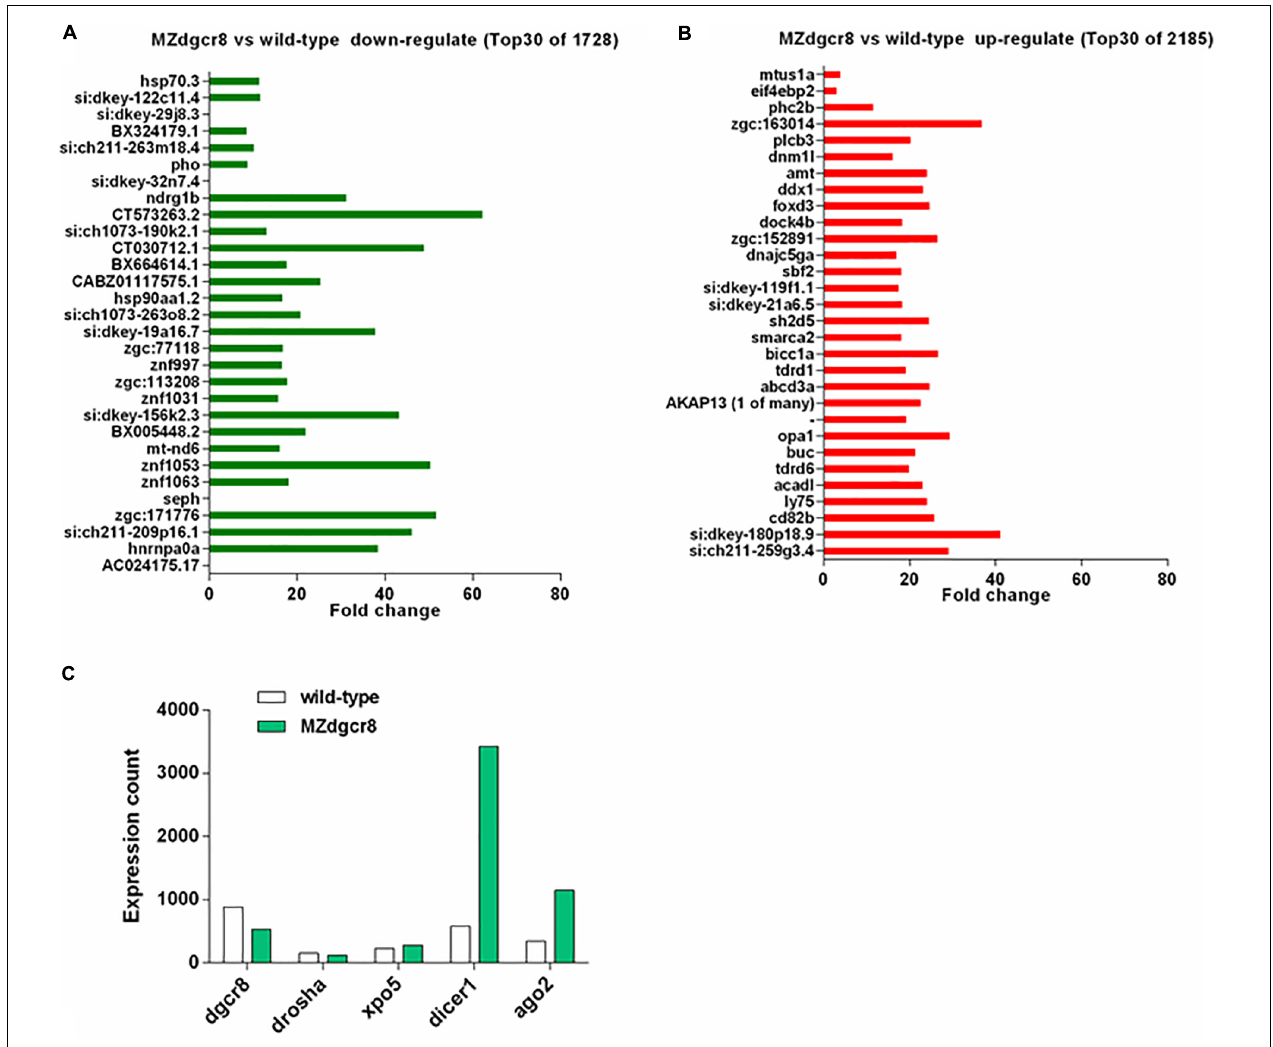
FIGURE 7 | mRNA expression variation in wild-type and MZ dgcr8 embryos during 30% epiboly stage. (A) Top 30 downregulated genes from RNA-seq data. (B) Top 30 upregulated genes from RNA-seq data. (C) Expression count of miRNAs biogenesis related